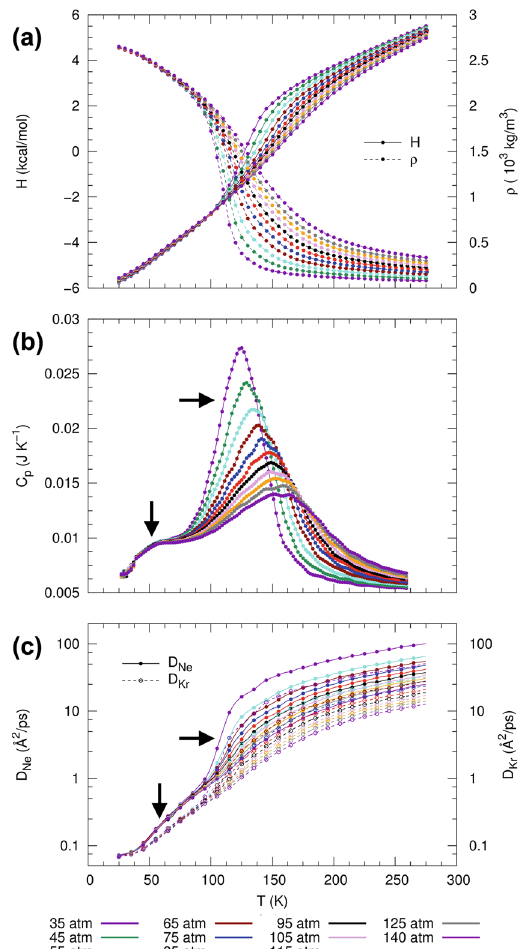
Figure 3. Thermophysical properties and response functions for equimolar Ne/Kr mixture with type-III phase behavior, showing ( a ) supercritical isobars of enthalpy H and density ρ , ( b ) isobaric heat capacity C p as a function of temperature, and ( c ) diffusion coefficients ( D Ne and D Kr ) as obtained along the simulated